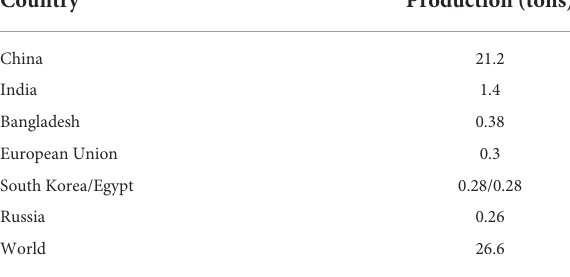
TABLE 2 Estimated garlic ( Allium sativum ) production